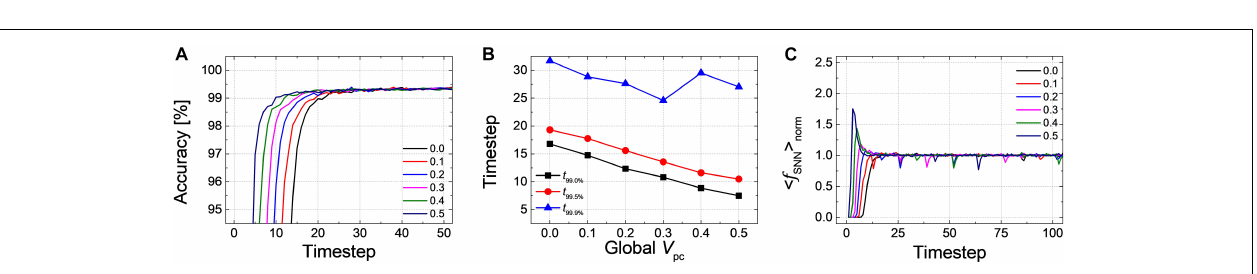
FIGURE 2 | < f SNN > norm , the averaged firing rate over all the test samples normalized by ANN’s activation in the input and output layers according to the simulation timestep for (A) Net 1 , (B) Net 2, and (C) Net 3 . < f SNN > norm of the output layer suffers from the latency compared with that of the input layer.